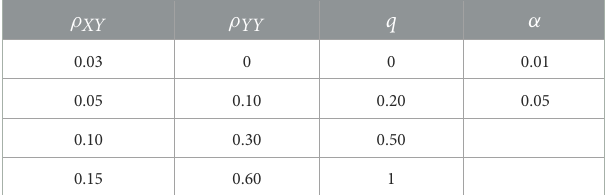
TABLE 2 Possible values of simulation